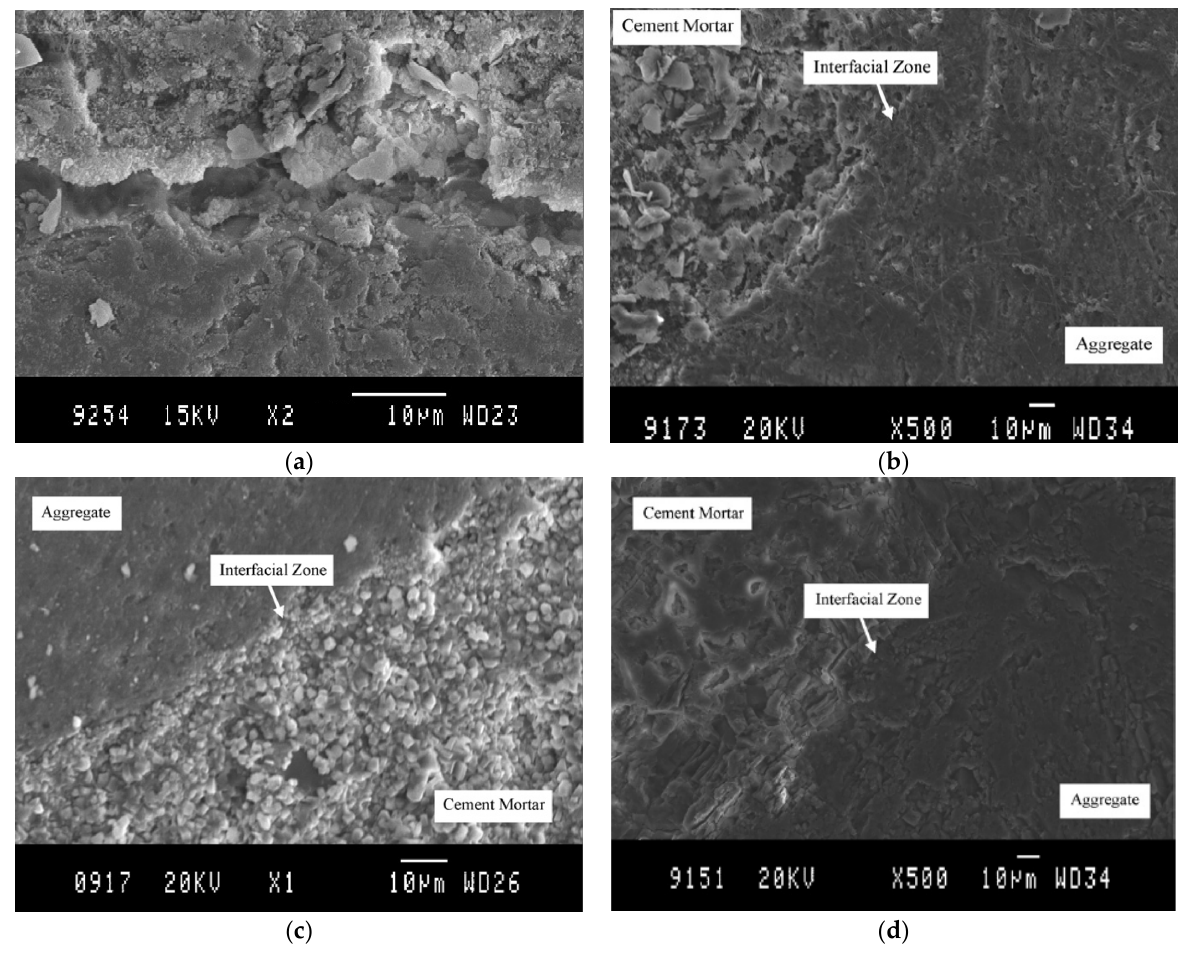
Figure 5. ( a ) ITZ for concrete with RCA without pre-soaking treatments; ( b ) interfacial zone for RCA treatment with HCl; ( c ) interfacial zone for RCA treatment with H 2 SO 4 ; and ( d ) interfacial zone for RCA treatment with H 3 PO 4 (Tam et al. [15]).